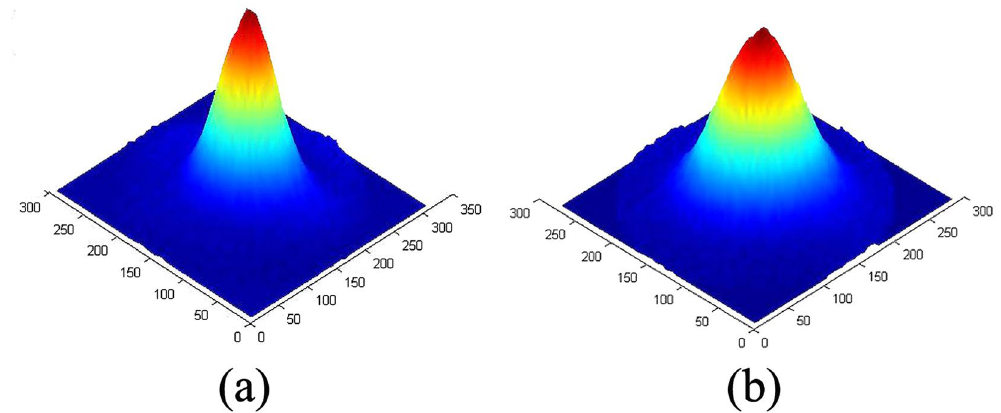
Figure 6. 3D images of beam intensity profile at 3 μ m ( a ) and at 4 μ m ( b